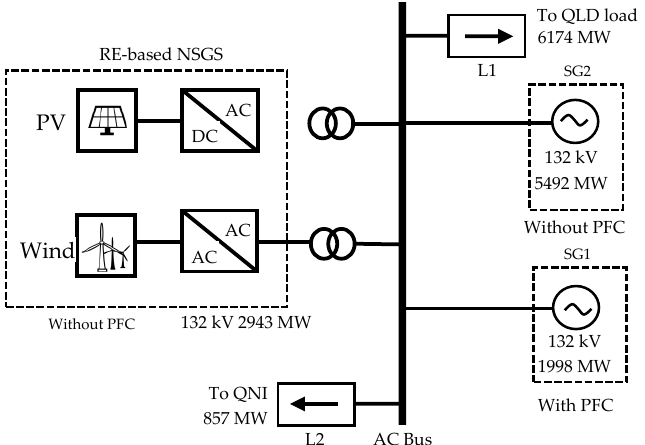
Figure 4. A simplified power system model with two lumped SGs and non-synchronous generating